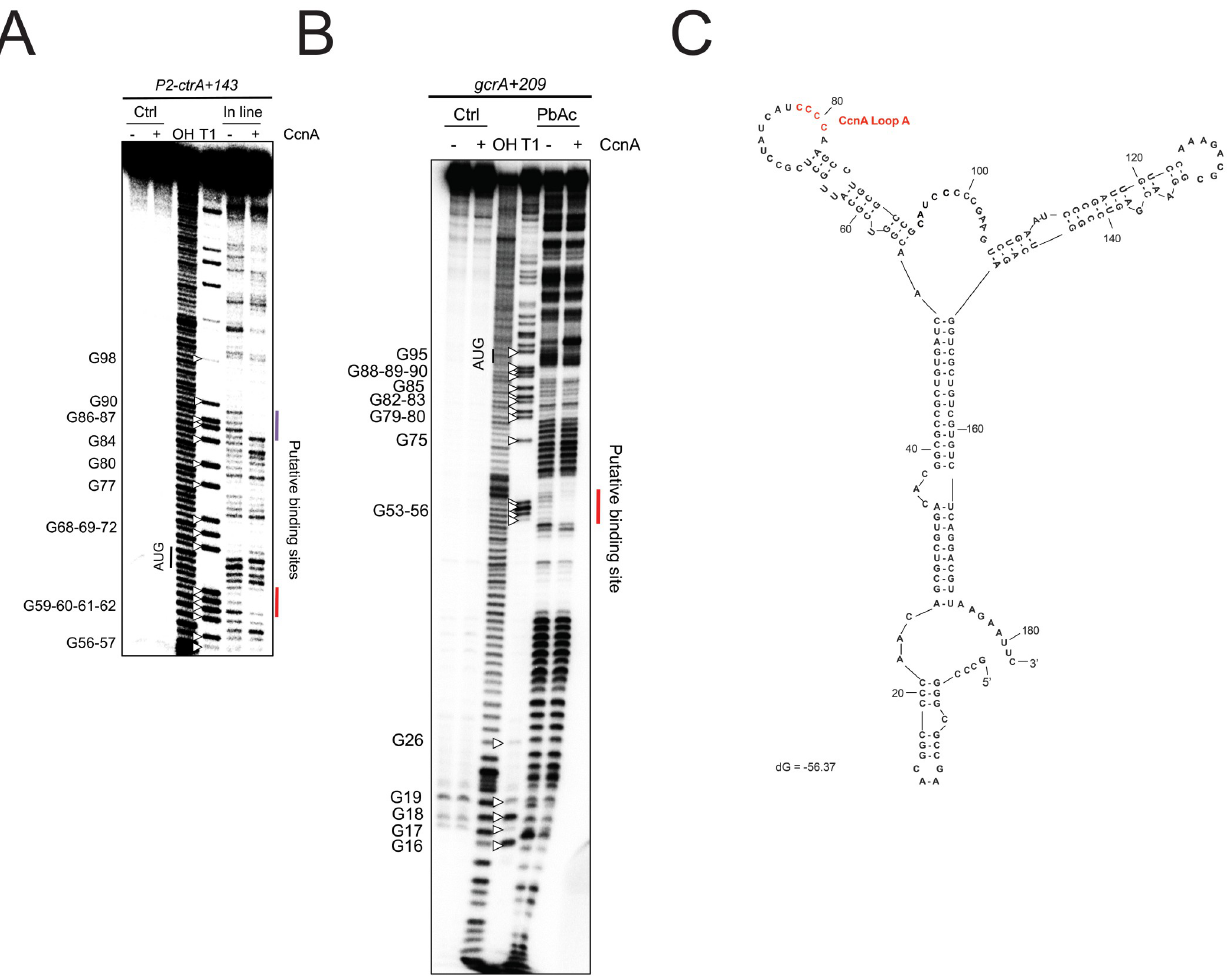
Fig 4. CcnA interacts directly in vitro with the 5 0 UTR of P2- ctrA mRNA and 5 0 UTR of gcrA mRNA. (A) Inline (MgCl 2 ) probing of 5 0 end-radiolabeled P2- ctrA +143 incubated in presence (+) or absence ( − ) of CcnA ncRNA. OH, alkaline ladder; T1, RNase T1 ladder. The numbers to the left indicate sequence positions with respect to the +1 of the transcript. ( B) Lead acetate probing of 5 0 end-radiolabeled gcrA +209 incubated in presence (+) or absence ( − ) of CcnA ncRNA. OH, alkaline ladder; T1, RNase T1 ladder. The numbers to the left indicate sequence positions with respect to the +1 of the transcript. ( C) Secondary structure of CcnA RNA predicted using mFold algorithm [48]. The predicted free energy of the thermodynamic ensemble is − 56.37 kcal/mol. CcnA Loop A is shown in red and is composed of a stretch of « CCCC ». CcnA, cell cycle noncoding RNA A; ncRNA, noncoding RNA; 5 0 UTR, 5 0 untranslated